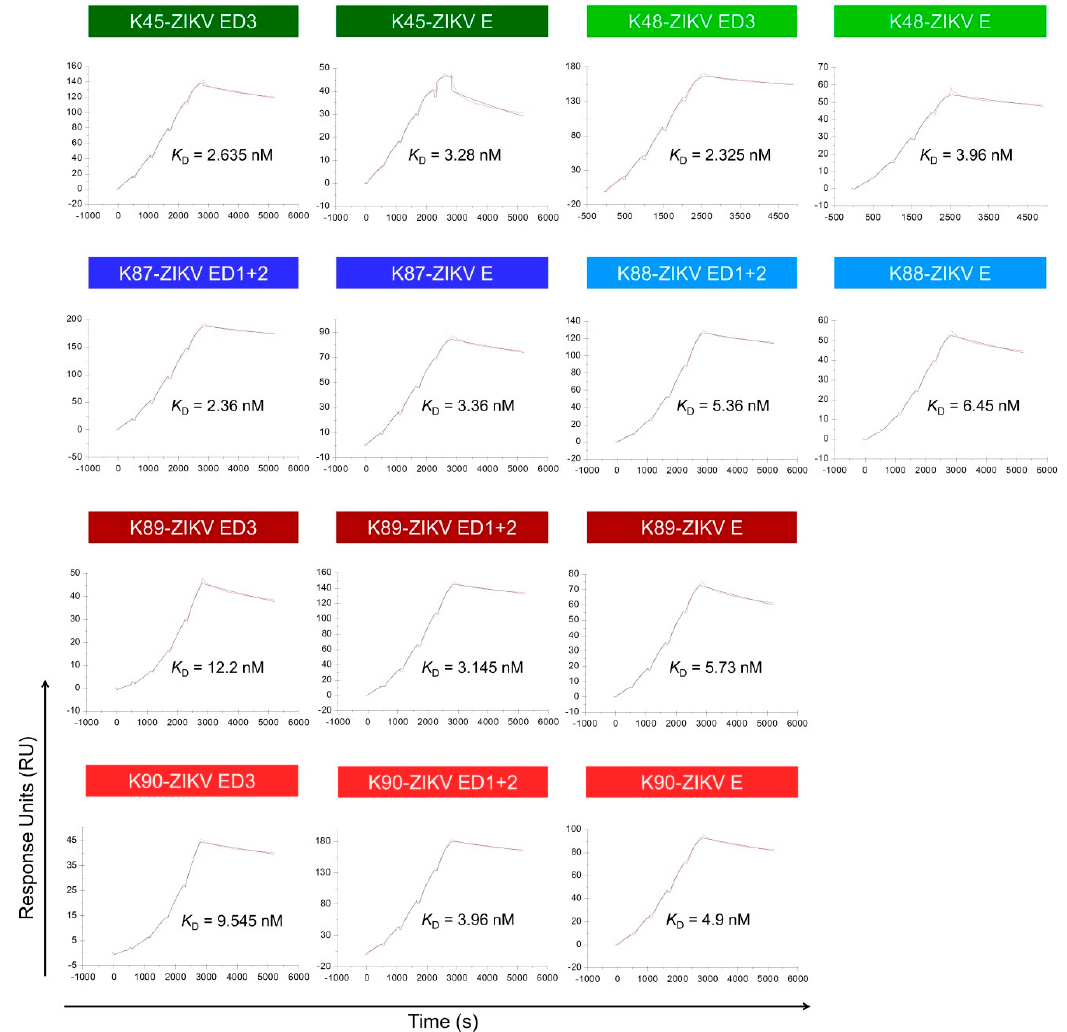
Figure 8. SPR analysis of the interaction between the purified antibodies and ZIKV E domains. The purified ZIKV E domains were immobilized on CM5 chip and the purified sera were applied in dilution series (12.5–200 nM) using a single cycle mode. The background binding to the blank-immobilized flow cell was subtracted, and the experimental data were fitted in a 1:1 binding model. The experimental data are shown in red lines and the fitted data in black lines. Sensograms from one of two independent experiments are shown. The shown K D values are mean values of the two independent experiments. Table 5. K D values for the binding of the purified antibodies to the different ZIKV E domains. Binding to ZIKV Binding to ZIKV ED3 Binding to ZIKV E ED1+2